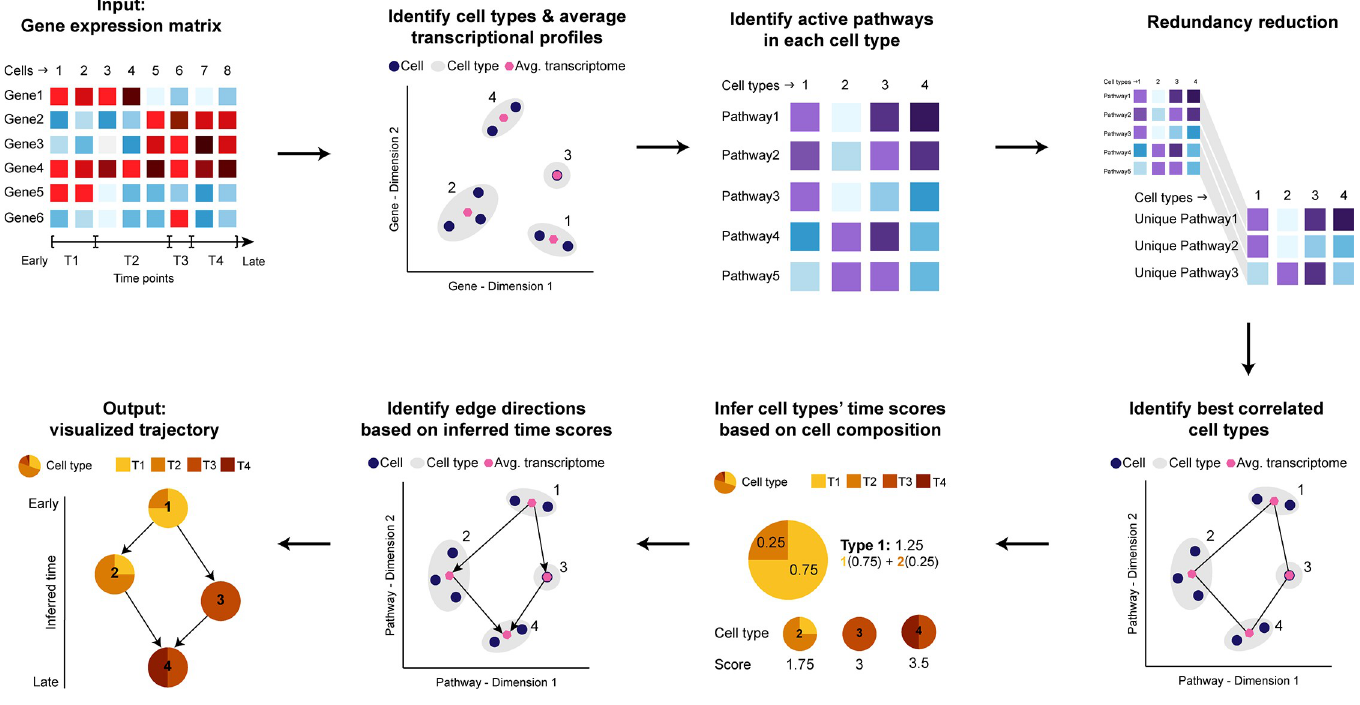
Fig 1. Schematic of the Tempora